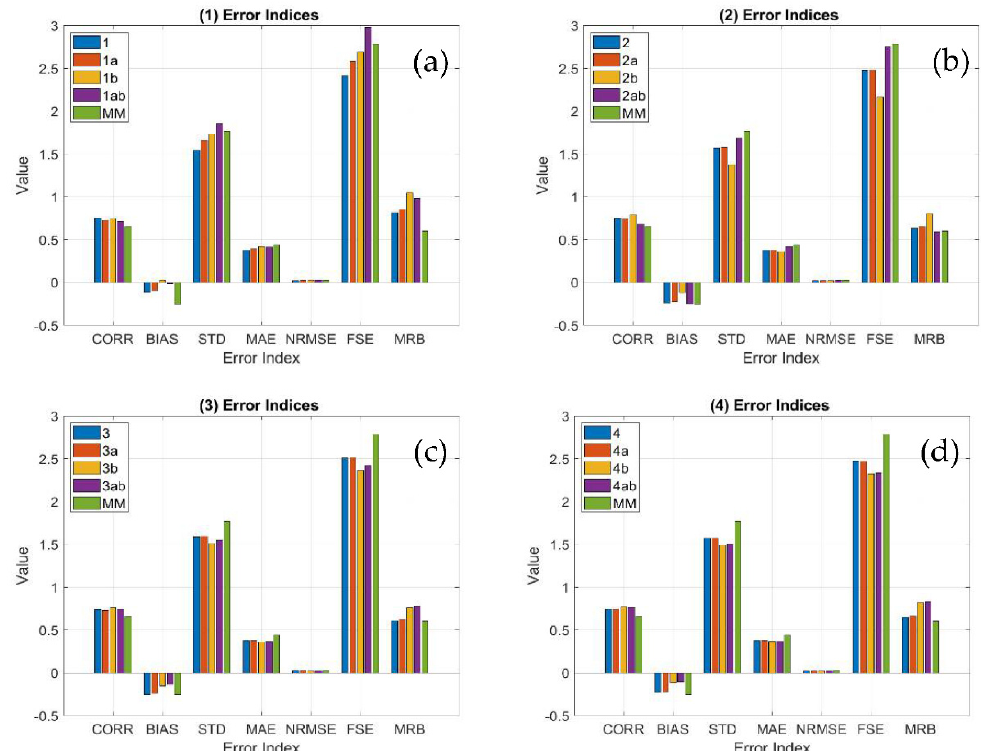
Figure 14. Overall error indices of both the tested merging methods and the single radar. ( a ) ID 1-1ab, ( b ) ID 2-2ab, ( c ) ID 3-3ab, ( d ) ID 4-4ab (see Table 3), tested in the composite domain using the whole dataset listed in Table 4.